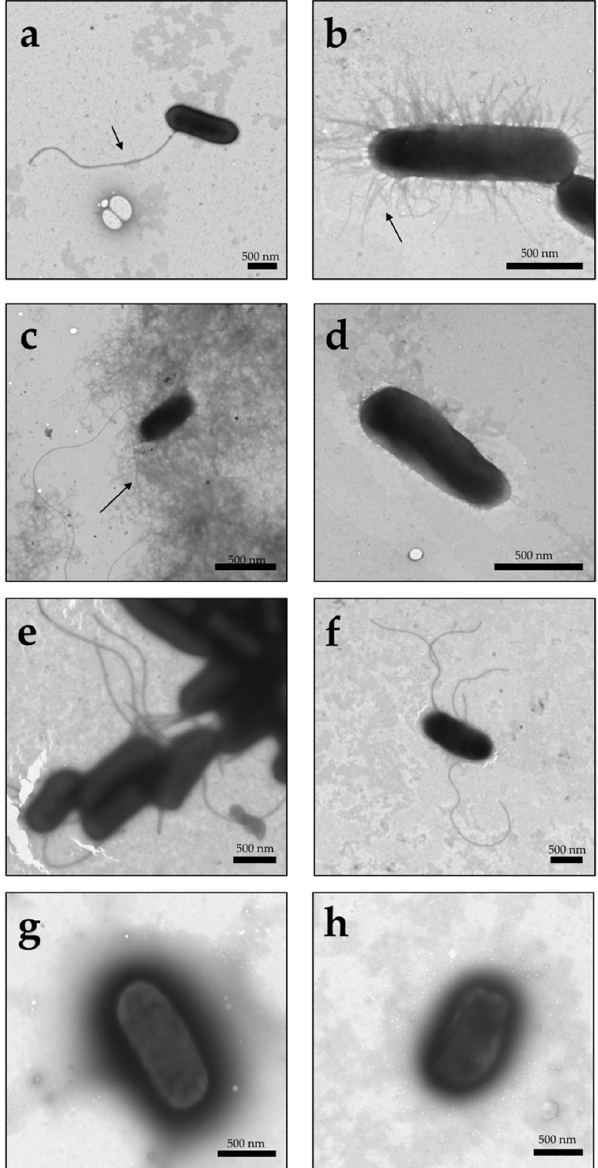
Figure 1 . Visualization of type I fimbriae, curli and flagella of the UPEC strain CFT073 by TEM. Bacteria were stained with 1.0% PTA and visualized by TEM. The arrows show ( a ) Flagellum; ( b ) type I fimbriae; ( c ) curli fimbriae. Moreover, ( d ) CFT073Δ fliC strain; ( e ) CFT073Δ fimH strain; ( f ) CFT073Δ csgA strain; ( g ) CFT073Δ fimH Δ fliC strain; ( h ) CFT073Δ csgA Δ fimH strain. The scale bars are 500 nm.